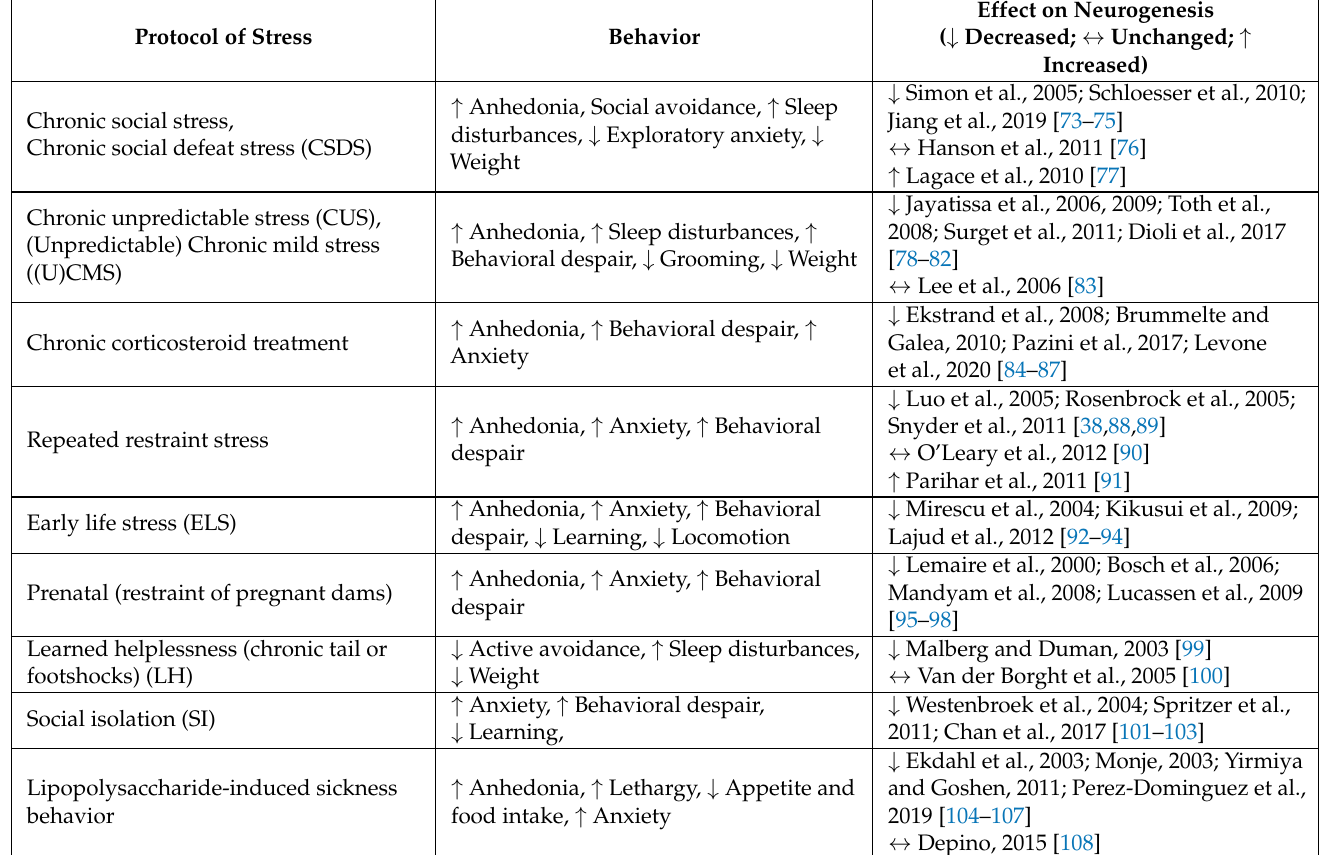
Table 1. Summary of different chronic stress protocols in rodents, their behavioral outcome, and effect on adult hippocam- pal